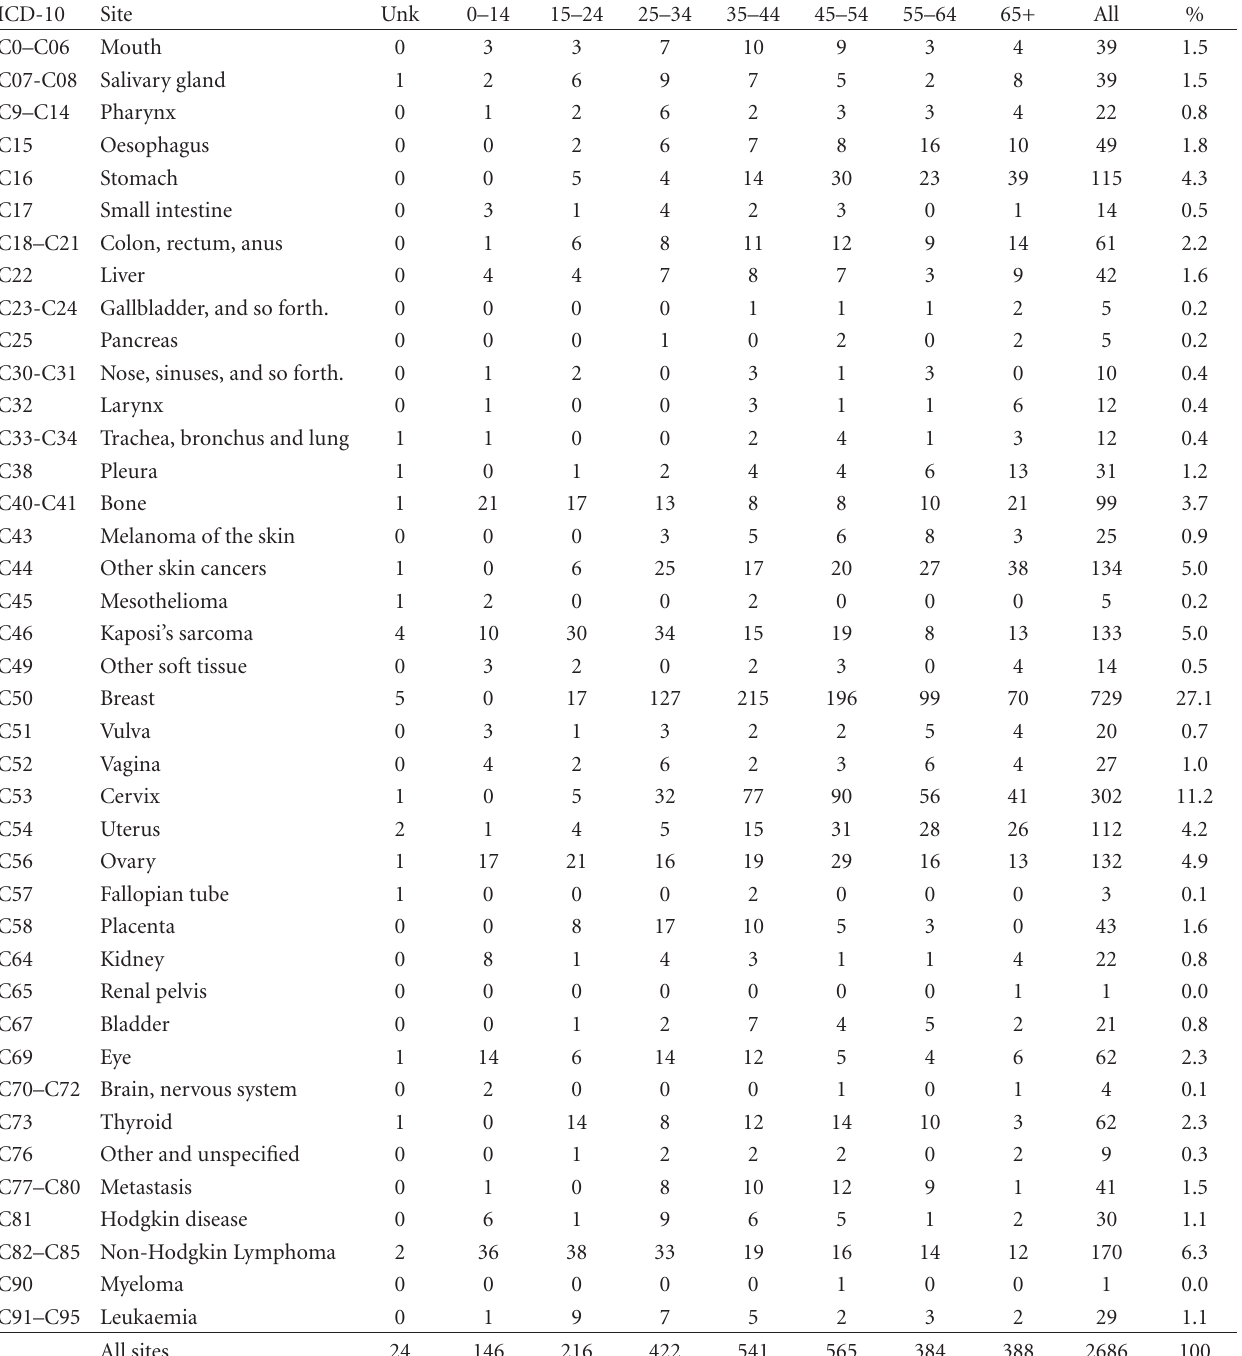
Table 3: Distribution of cancers by site and age in